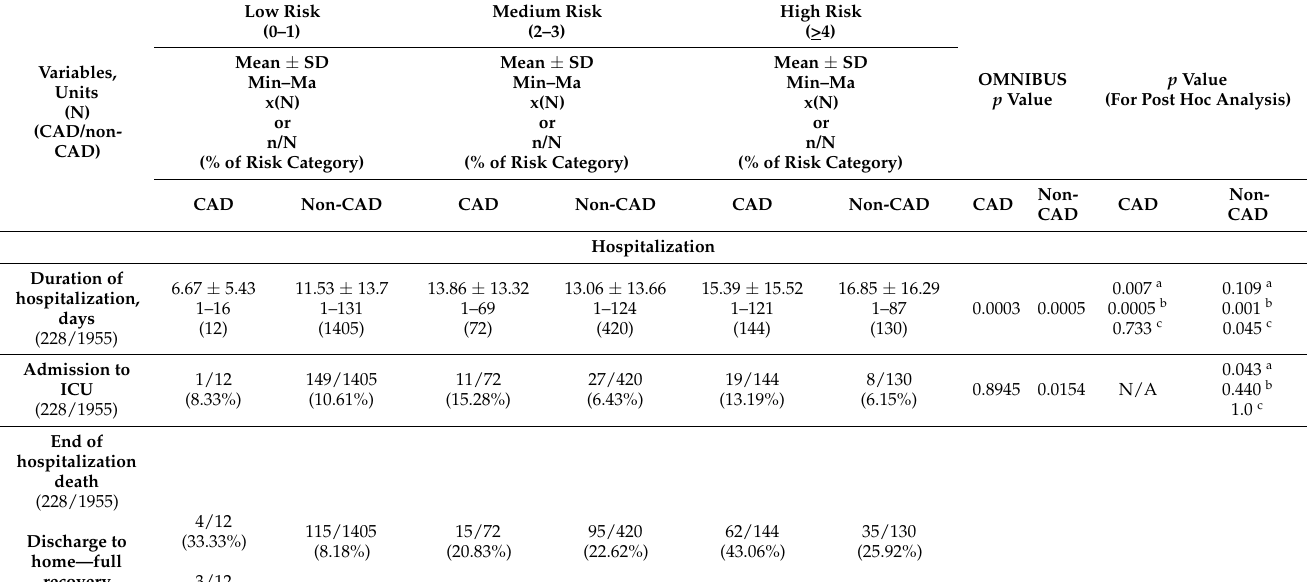
Table 14. Clinical non-fatal events and hospitalization outcomes in the C 2 HEST risk strata in CAD and non-CAD